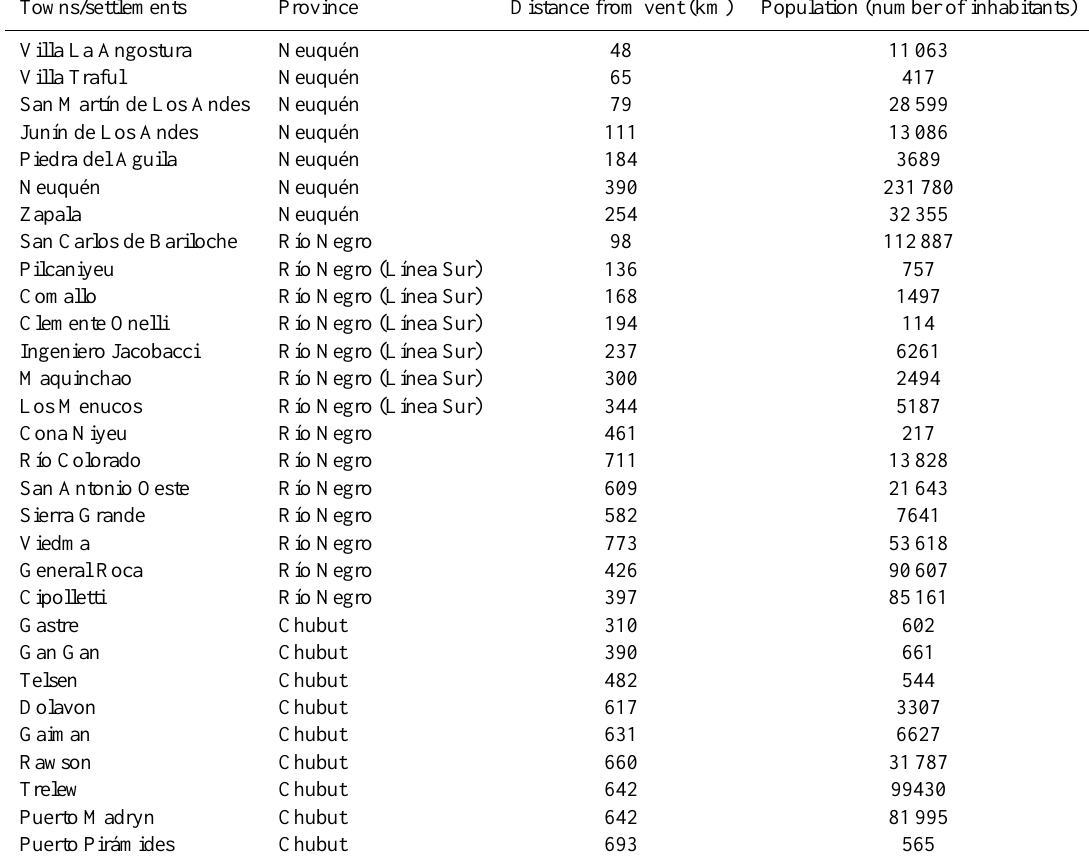
Table 6. Distance from vent and population of towns and settlements affected by tephra fallout.